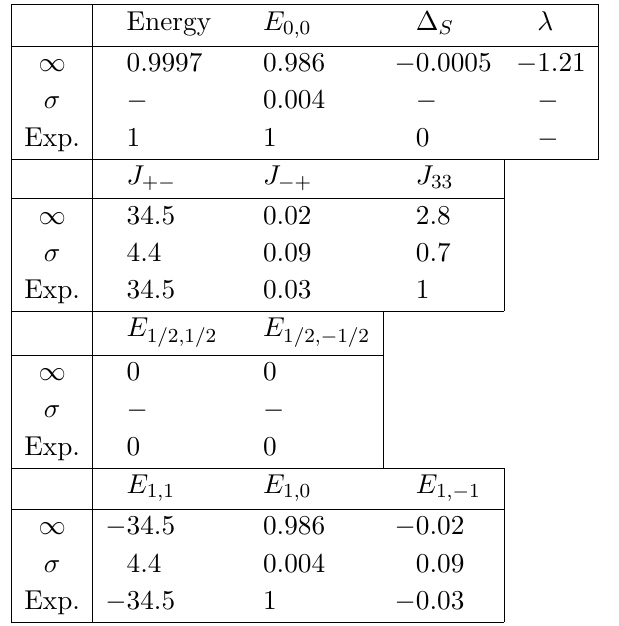
Table 17 . Extrapolations of observables and the marginal parameter of the special complex marginal solution in the k = 2 model with J = 1 boundary conditions. The expected values are based on 2 θ = 0 and ρ ≈ 5 . 9 . We do not have good error estimates for some observables.